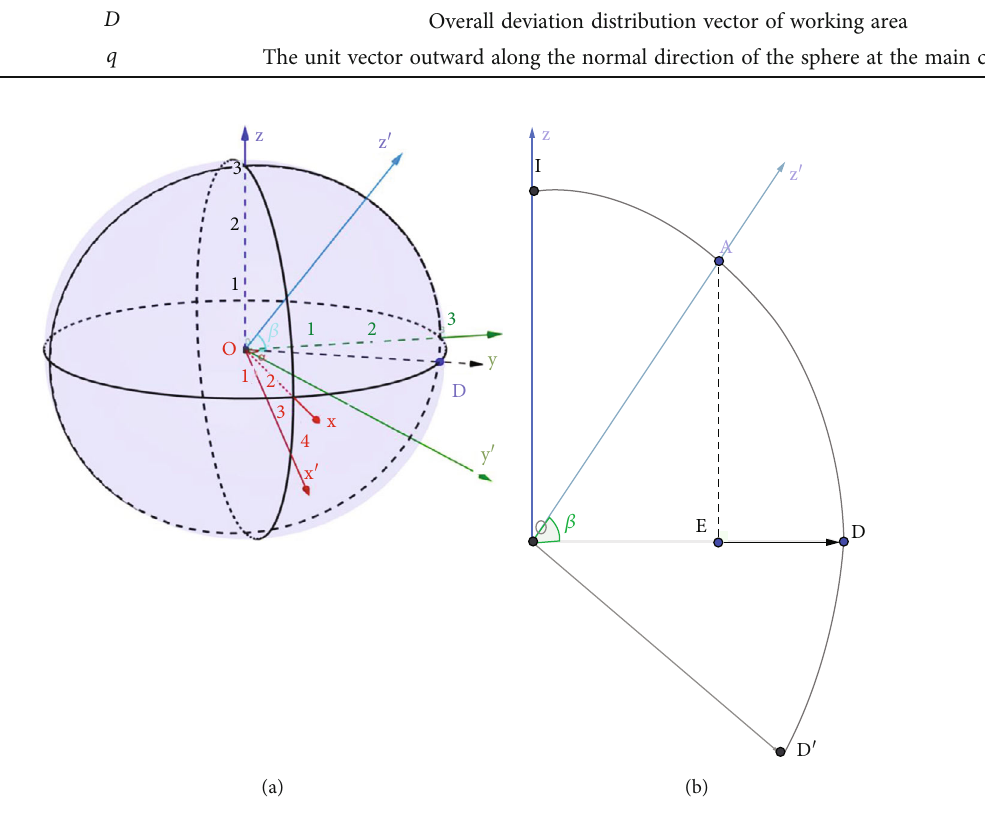
Figure 1: Rotation diagram of spatial follow-up coordinate system (a) and surface rotation diagram